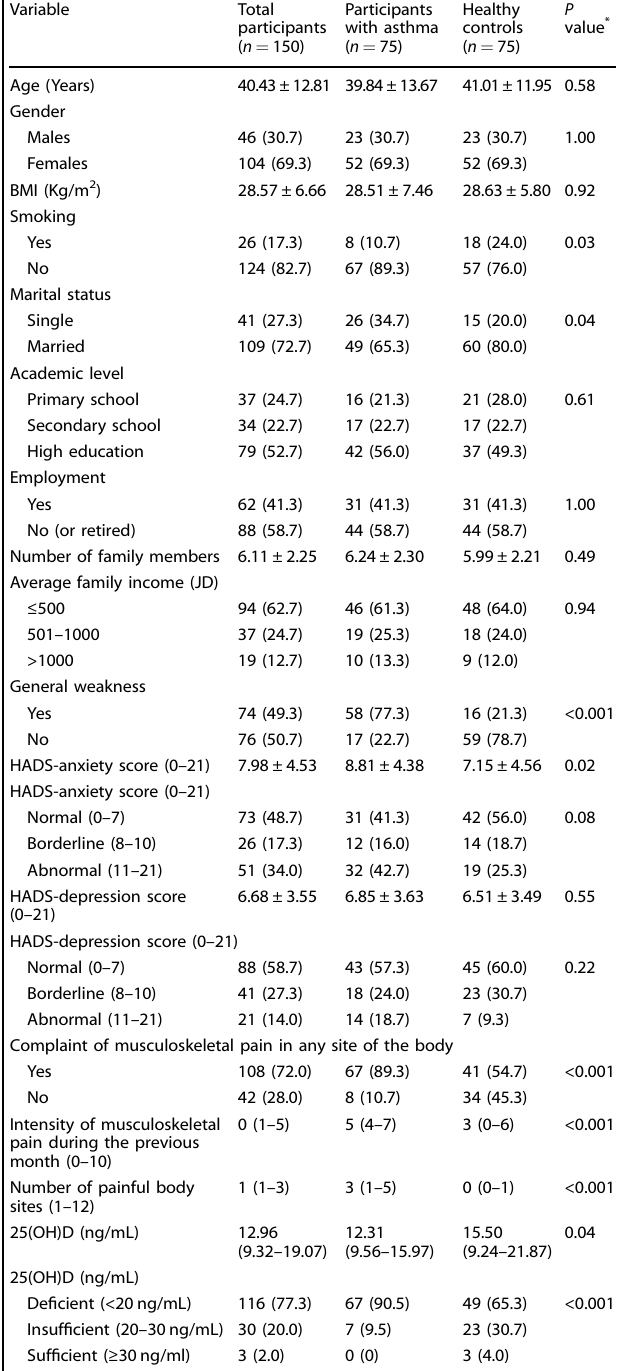
Table 1. General characteristics and differences in study variables between participants with asthma and healthy